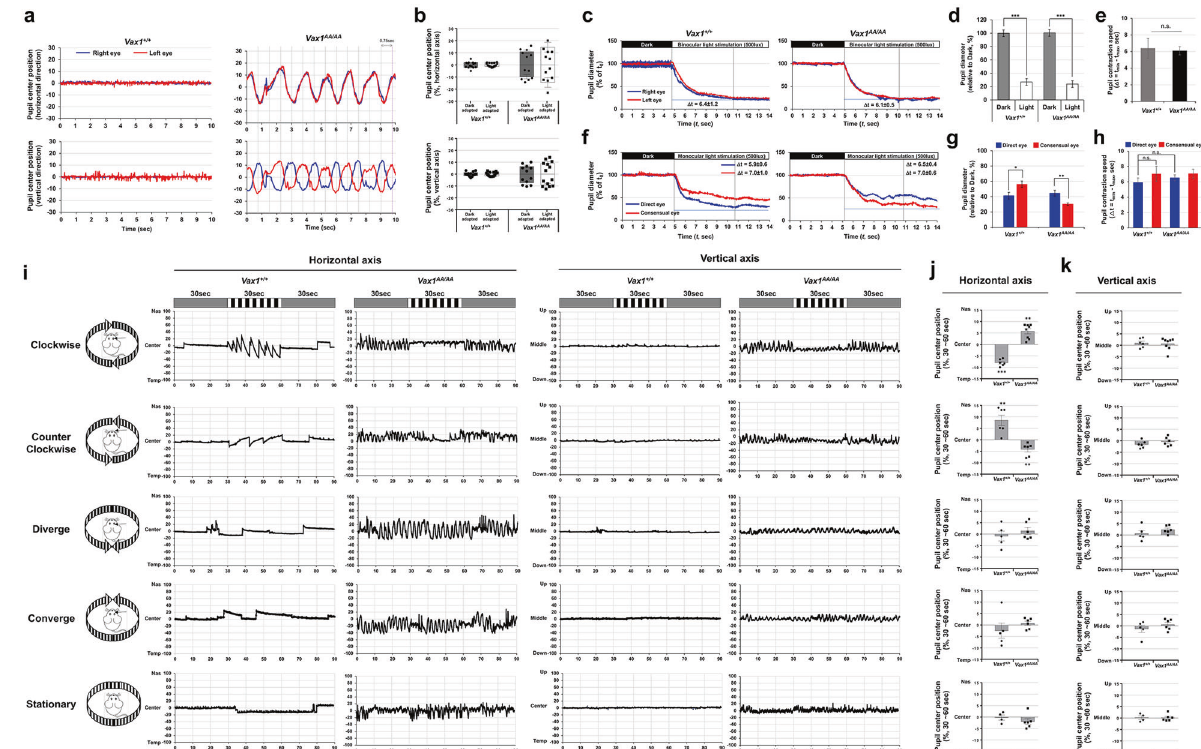
Fig. 8 Visuomotor anomalies of Vax1 AA/AA mice. a Positions of pupil centers in the right and left eyes of head- fi xed P45 Vax1 + / + and Vax1 AA/AA mice were tracked by the iSCAN rodent eye tracking system while the mice were kept in the dark. The relative positions of the pupil centers against the position at time 0 (t 0 ) were plotted in the oscillograms. b Peak positions that the pupil centers moved at vertical and horizontal axes were measured, and the averages are shown in graphs. Error bars are SDs ( n = 6). c The P45 mice were adapted to the dark for 30 min and illuminated with a room light. f Alternatively, the dark-adapted mice were illuminated monocularly with a point light. Pupil diameters were measured by an iSCAN eye tracking system before and after the illuminations. Relative pupil diameters against t 0 are plotted in oscillograms. ( d and g ) Average pupil diameters of the mice in dark (t 0 ~ t 5 ) and light (t 5 ~ t 14 ) conditions are measured and shown in graphs. e and h The values in the graphs are the contraction speed, which is de fi ned as the time taken to reach the minimal pupil diameter from the maximum diameter ( Δ t = t min – t max ). Error bars are SD ( n = 6 [ Vax1 + / + ] and n = 7 [ Vax1 AA/AA ]). *, p < 0.05; ** , p < 0.01; ***, p < 0.005. i Head- fi xed P45 Vax1 + / + and Vax1 AA/AA mice were positioned in a chamber surrounded by monitors, which displayed a gray background. The center positions of the pupils in the right and left eyes were marked and then tracked by the iSCAN rodent eye tracking system, while the mice exposed to the monitors displayed black and white vertical stripes (0.2 c/d), which were moving in the indicated directions for 30 seconds. The relative positions of the pupil centers of the right eyes against the position at t 0 are plotted in the oscillograms. Peak positions of the pupil centers between 30 sec and 60 sec at horizontal ( j ) and vertical ( k ) axes were collected, and the averages are shown in graphs. Error bars are SDs ( n = 6 [ Vax1 + / + ] and n = 8 [ Vax1 AA/AA